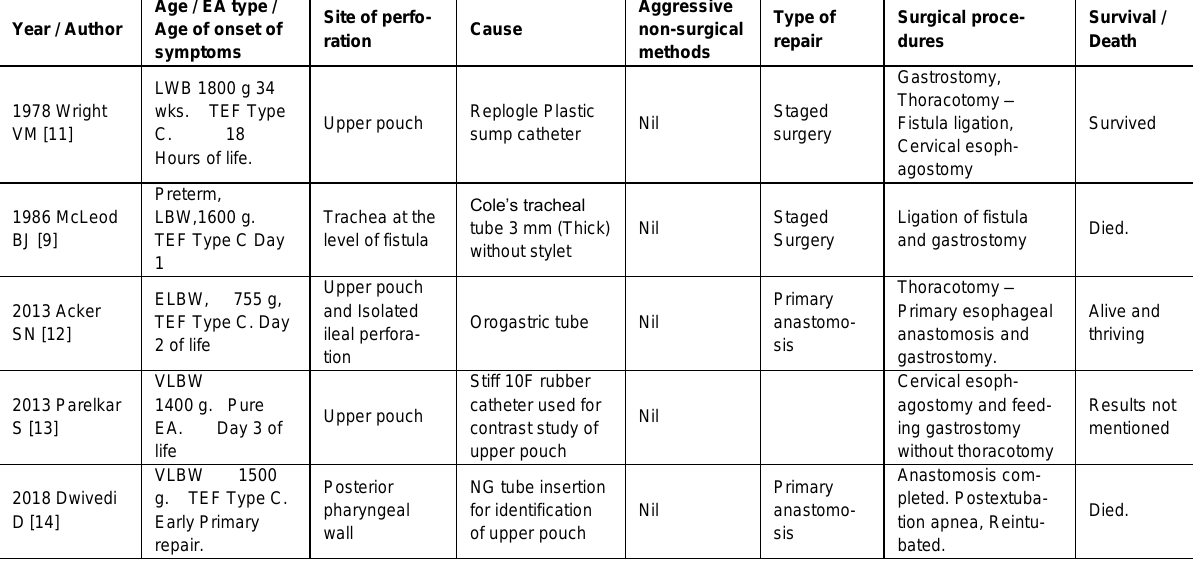
Table 1: Cases of iatrogenic tracheoesophageal injury in EA with or without